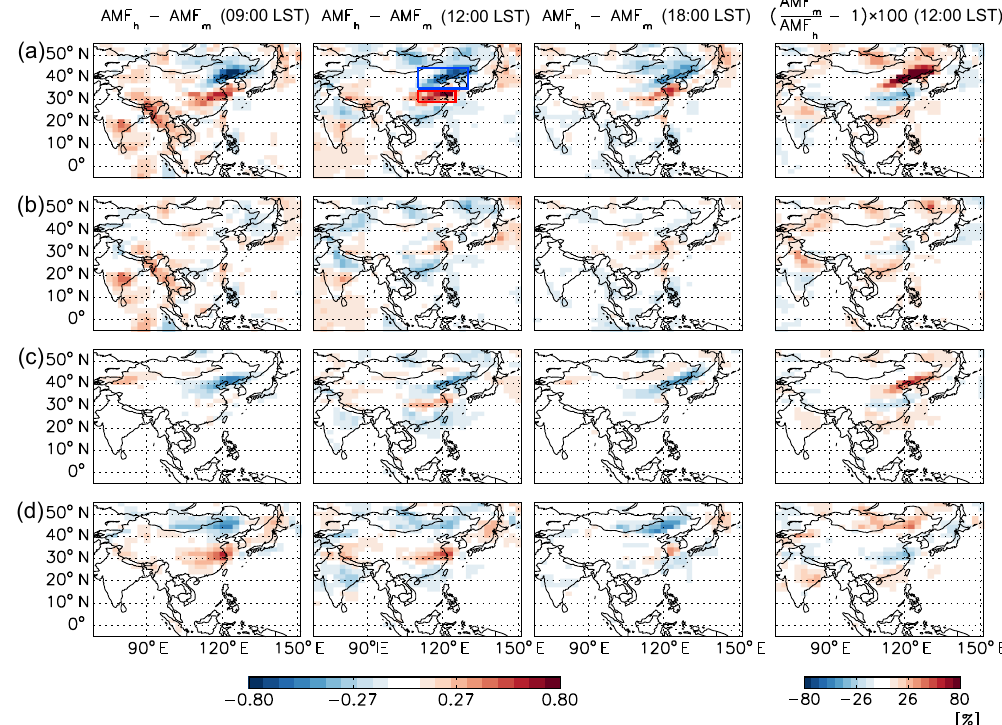
Figure 5. (a) Differences between AMF h and AMF m values and relative contributions to them by the temporal changes in (b) HCHO profiles, (c) aerosol optical properties, and (d) aerosol vertical distributions. The first to third columns are results at 09:00, 12:00, and 18:00LST at Seoul on 21 June 2009. The fourth column gives percentage differences for the ratio of AMF m to AMF h indicating changes in HCHO VCDs with AMF h relative to those with AMF m at 12:00LST. Blue and red boxes denote regions of shielding and enhancement